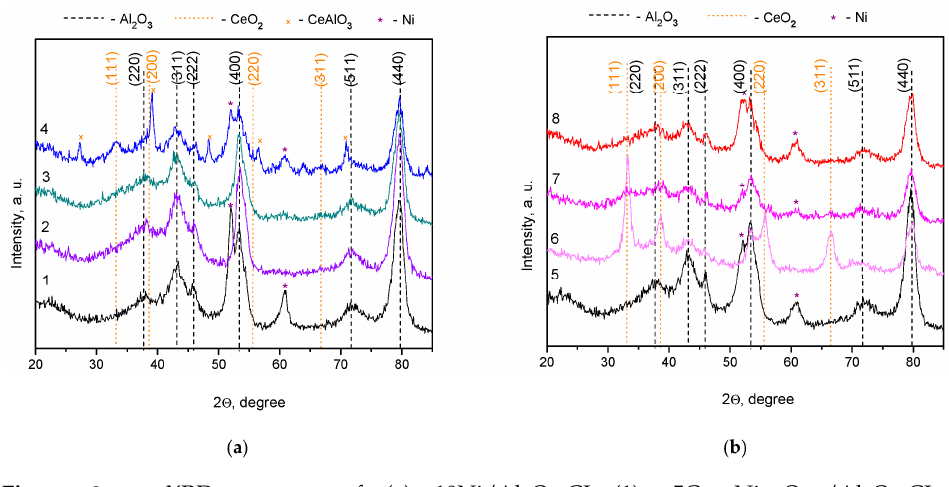
Figure 9. XRD patterns of ( a ) 10Ni/Al 2 O 3 -CI (1), 5Ce 0.2 Ni 0.8 O 1.2 /Al 2 O 3 -CI (2), 10Ce 0.2 Ni 0.8 O 1.2 /Al 2 O 3 -CI (3), 20Ce 0.2 Ni 0.8 O 1.2 /Al 2 O 3 -CI (4), ( b ) 10Ni/Al 2 O 3 -SG (5), 20Ce 0.8 Ni 0.2 O 1.8 /Al 2 O 3 -SG (6), 20Ce 0.5 Ni 0.5 O 1.5 /Al 2 O 3 -SG (7), and 20Ce 0.2 Ni 0.8 O 1.2 /Al 2 O 3 -SG (8) catalysts after the reaction. To determine the amount of carbonaceous deposits formed during the reaction, the samples were examined by thermal analysis in the air (Figure 10). In the low-temperature region (T < 250 °C), a weight loss is observed, accompanied by an endothermic effect and associated with the desorption of water and volatile intermediates. Then, in the temper- ature range of 300–500 °С, weight gain occurs, which is due to the oxidation of nickel metal to nickel oxide. The slight decrease in weight as the temperature rises further can be attributed to the burnout of carbonaceous deposits. It is accepted [60] that carbon ox- idation starts with amorphous carbon at a low temperature (up to 450 °C), followed by carbon nanotubes. The content of carbonaceous deposits is slightly different among the samples and is low (0.3–0.7 wt.%) in comparison with literature data: the content of coke (C) is equal to 50 wt.% for 12Ni/Al 2 O 3 catalyst [61], 2 wt.% for 12Ni–5Ce–5Fe/Al 2 O 3 [61], 3 wt.% for 5Ni/MgAl 2 O 4 [62], 1.5 wt.% for 3B-Ni/SBA-15 [63], and 0.2–47.9 wt.% for 10Ni/ZrO 2 with different properties of ZrO 2 support [64] in the bi-reforming of CH 4 . It should also be noted that, according to thermodynamic calculations, the maximum yield of carbon in the СH 4 -CO 2 -H 2 O system is observed in the temperature range of 500–800 °C [25]. Thus, the fact that the catalysts contain low coke content after testing under adverse conditions testifies to their excellent anti-coking properties. Both the high Ni dispersion and cerium compounds play a positive role in biogas reforming. In particular, CeAlO 3 can react with CO 2 to form CO and CeO 2 , which oxidizes the precursors of carbonaceous residues on the Ni–support interface, restoring the CeAlO 3 sites [39].